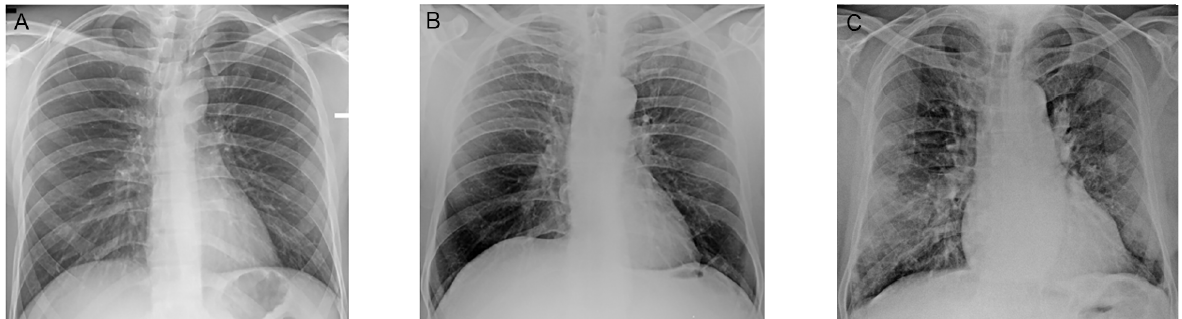
Figure 4. Radiographs of three different COVID-19 patients who presented with fever and cough at different time frames from disease onset. (a) A 32-year-old man who presented one day after symptom onset. Radiograph assessment of lung edema (RALE) scoring: reader 1: 0; reader 2: 0. (b) A 64-year-old man who presented three days after symptom onset. RALE scoring: reader 1: 1; reader 2: 2. (c) A 73-year-old man who presented seven days after symptom onset. RALE scoring: reader 1: 6; reader 2: